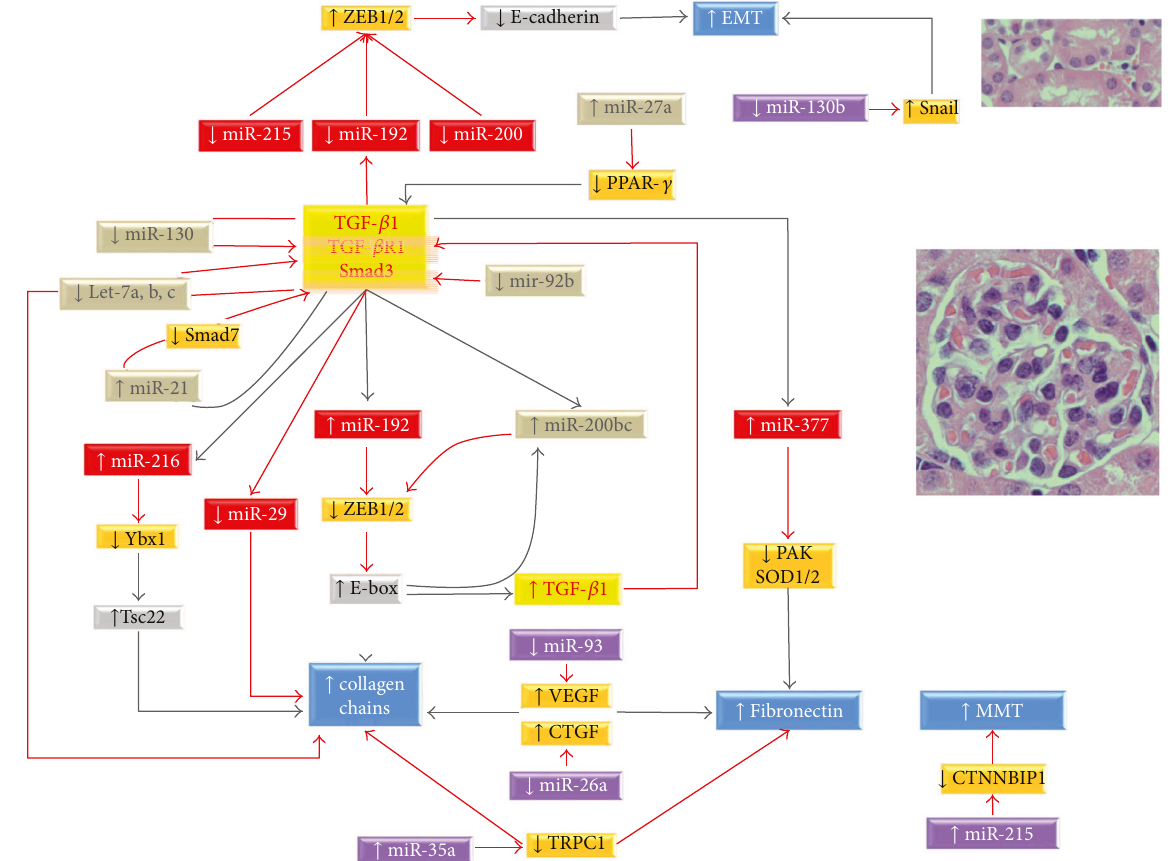
Figure 2: MicroRNAs involved in renal fi brosis in diabetes. MicroRNAs (miRNAs) implicated in glomerular (cream-coloured area) and tubule-interstitial (light purple-coloured area) fi brosis in diabetes. The image shows miRNAs in red boxes that are modulated by TGF- β 1 and directly control collagen/ fi bronectin expression, miRNAs in bronze boxes that enhance TGF- β 1 signaling, and miRNAs in purple boxes that a ff ect fi brosis independently of TGF- β 1. Target genes are shown in orange boxes. Grey lines indicate induction, while red lines indicate suppression of miRNA expression. EMT: epithelial mesenchymal transition; MMT: mesangial cell to myo fi broblast transition; CTNNBIP1: catenin beta interacting protein 1; TGF- β 1: transforming growth factor- β 1; TGFB-R1: transforming growth factor type 1 receptor; VEGF: vascular endothelial growth factor; CTGF: connective tissue growth